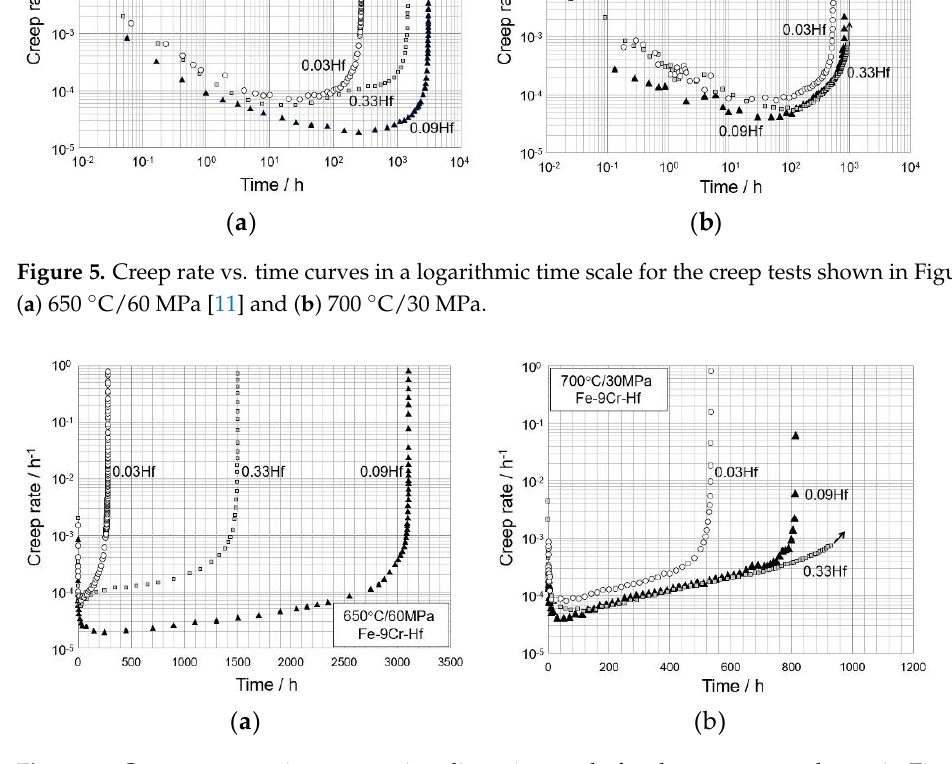
Figure 6. Creep rate vs. time curves in a liner time scale for the creep tests shown in Figure 3: ( a ) 650 °C/60 MPa [11] and ( b ) 700 °C/30 MPa.